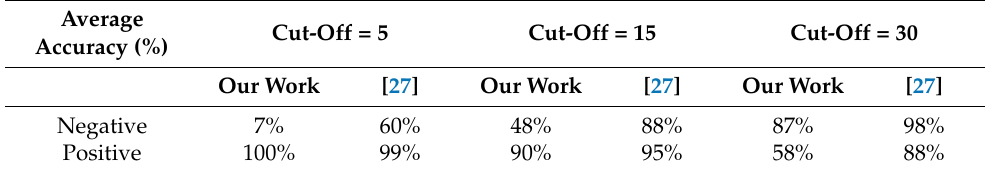
Table 12. REI estimation performance in comparison with a method from [27] for different